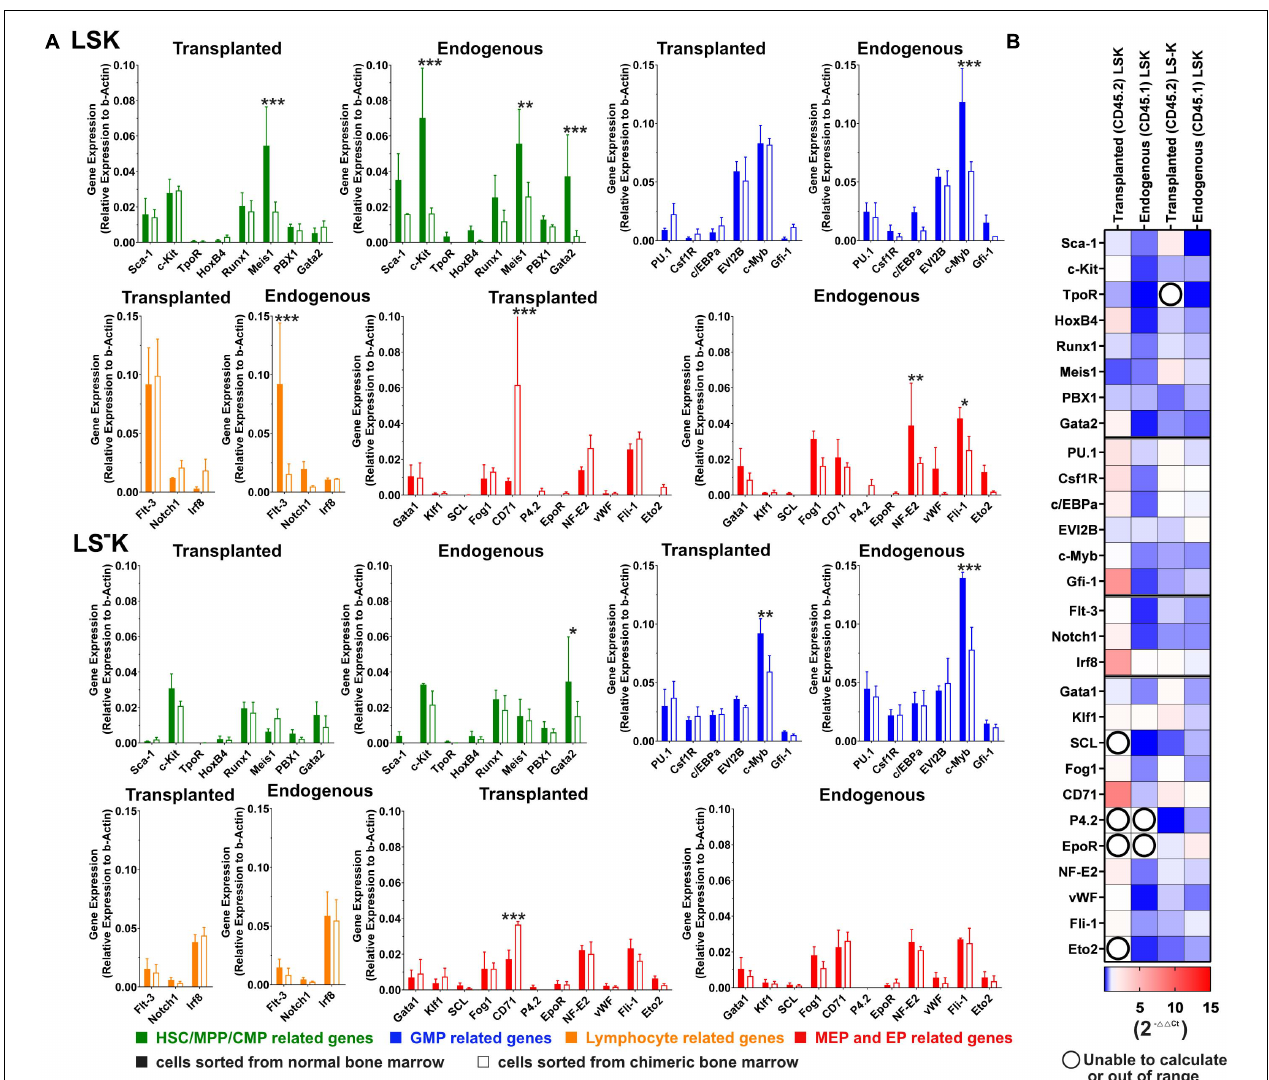
FIGURE 6 | Expression of selected genes in LSK and LS − K cells in chimeric hematopoiesis derive from transplanted and endogenous cells. (A) A 1/12 of femoral bone marrow (CD45.2) was transplanted to 6-Gy-irradiated CD45.1 mice (both females). The aim was to achieve an equal number of both cell types. There were approximately 65% of CD45.2 cells in the resulting chimeric bone marrow. The chimeric bone marrow was collected after 3 weeks, and CD45.1 and CD45.2 LSK and LS − K cells were sorted and their RNA analyzed by qR-PCR (2 − (cid:49) CT ). Solid column, control samples from LSK and LS − K cells of untreated mice; empty columns, LSK and LS − K cells from chimeric hematopoiesis, derived from transplanted or endogenous hematopoiesis reconstituting cells. The CD45.1/CD45.2 chimeric bone marrow was collected and pooled from four mice. The control CD45.1 bone marrow was pooled from three mice, and the CD45.2 control bone marrow was pooled from two mice. The bone marrow cells were collected from both tibias and femurs. Data represent the average of three to eight duplicates. Error bars represent SD. (B) Gene expression heatmap (2 − (cid:49)(cid:49) CT ): red, increased gene expression; blue, decreased gene expression; numbers show the fold change compared with control samples; white = 1 indicates no difference in gene expression between the experimental and the control samples; empty circles indicate results in which one of the compared values was out of the scale. GraphPad Prism created the heatmap. * p < 0.05, ** p < 0.01, *** p <